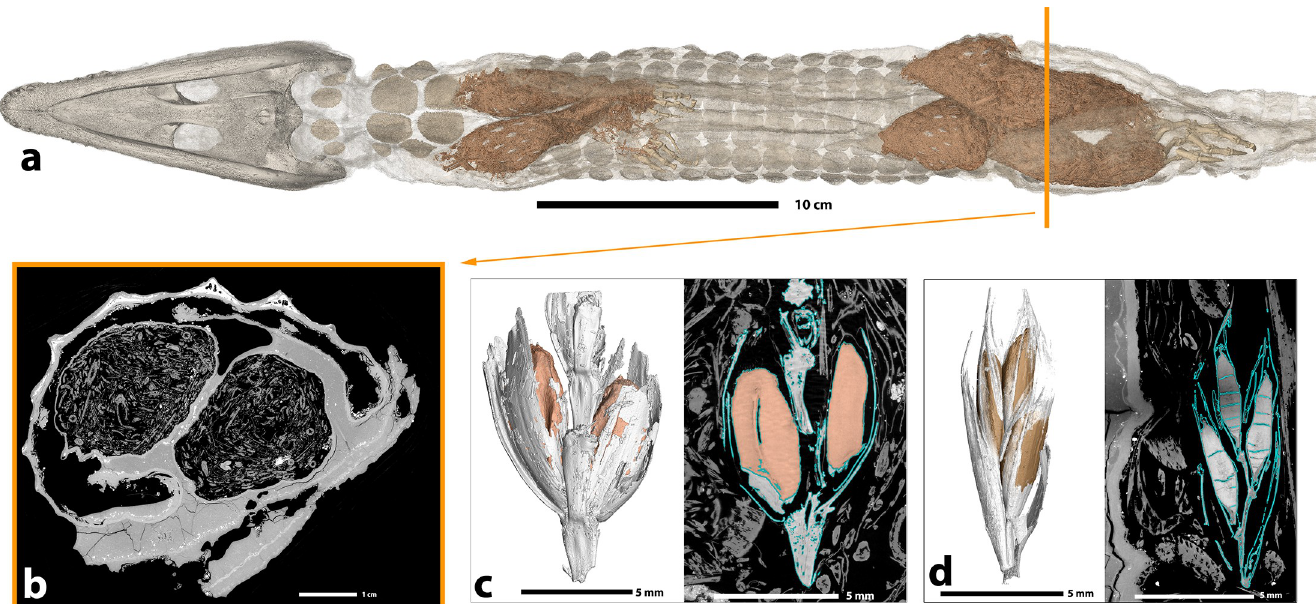
Fig 4. Details of the filling of the crocodile mummy MHNL 90001850. a. 3D rendering of the crocodile highlighting the filling, b. tomographic slice showing vegetal limb stuffing and thickness of the balm, c. and d. 3D renderings (left) and tomographic slices (right) of two of the well-preserved ears of grass within the filling.